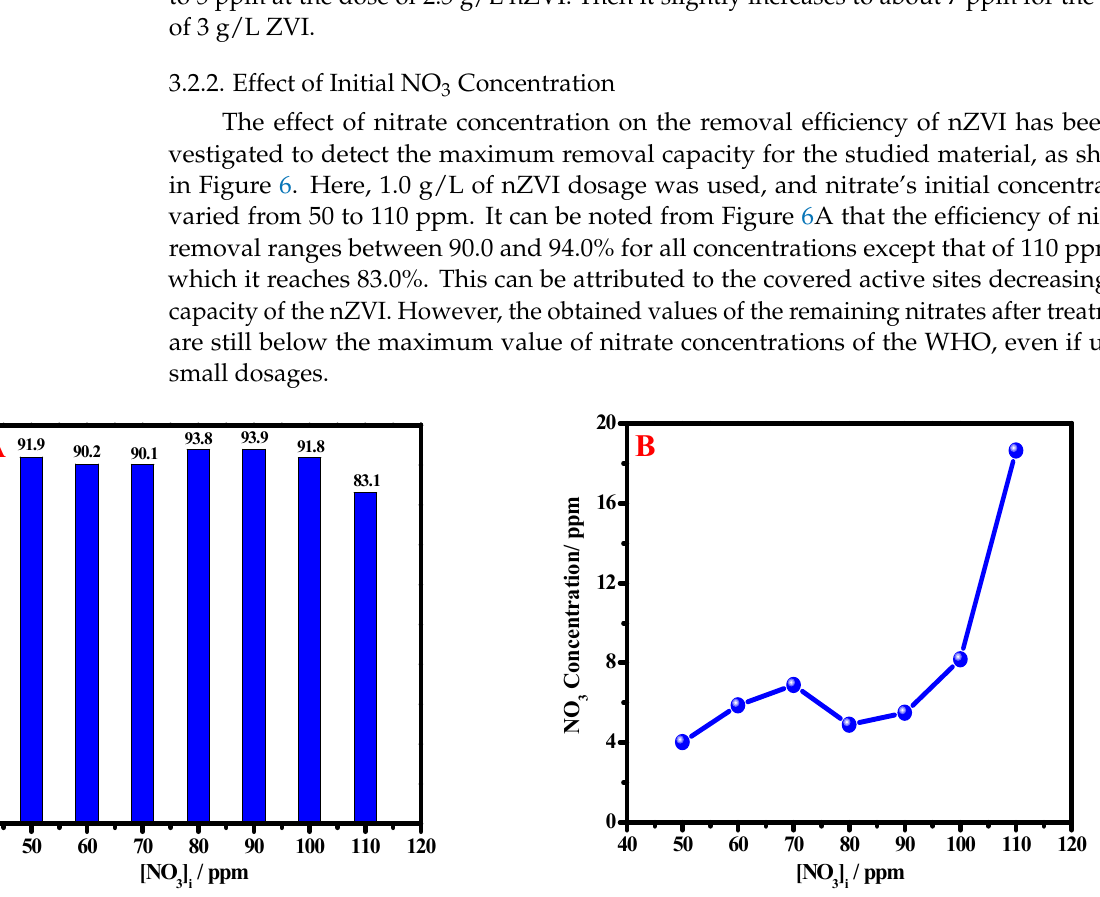
Figure 6. Removal efficiency with varying of the NO 3 initial concentration ( A ) and initial nitrate concentrations against the remaining concentration in ppm after treatment ( B ) at ambient temperature at 30 min contact time.